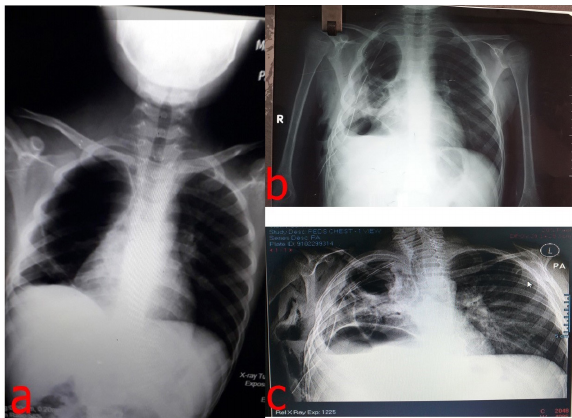
Figure 2. Job’s Syndrome Radiology. Note. (a) Chest X-ray performed on admission was normal. (b, c) Chest X-ray performed on March and April 2019 showed multiple thin-walled cysts filled with air consistent with